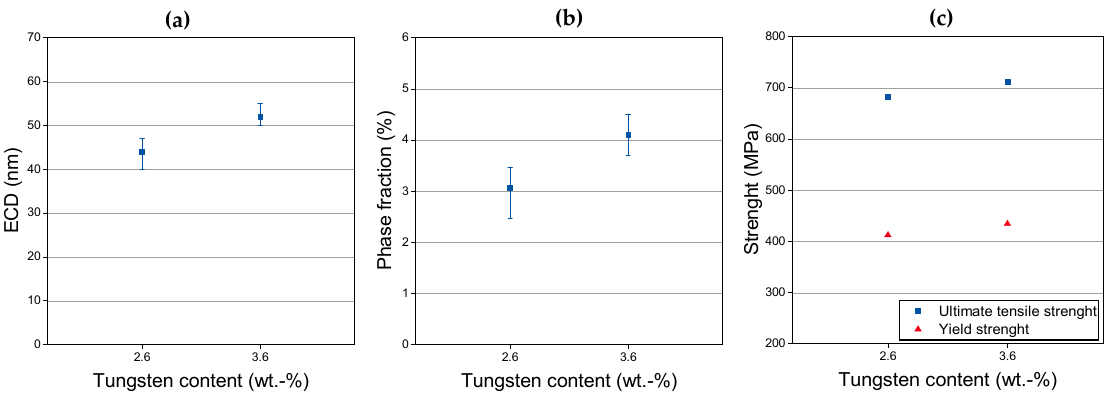
Figure 7. Results of the quantitative particle analysis: ( a ) particle size equivalent circle diameter (ECD), ( b ) phase fraction, and ( c ) ultimate tensile strength and yield strength of model alloys Fe17Cr2.6W and Fe17Cr3.6W.